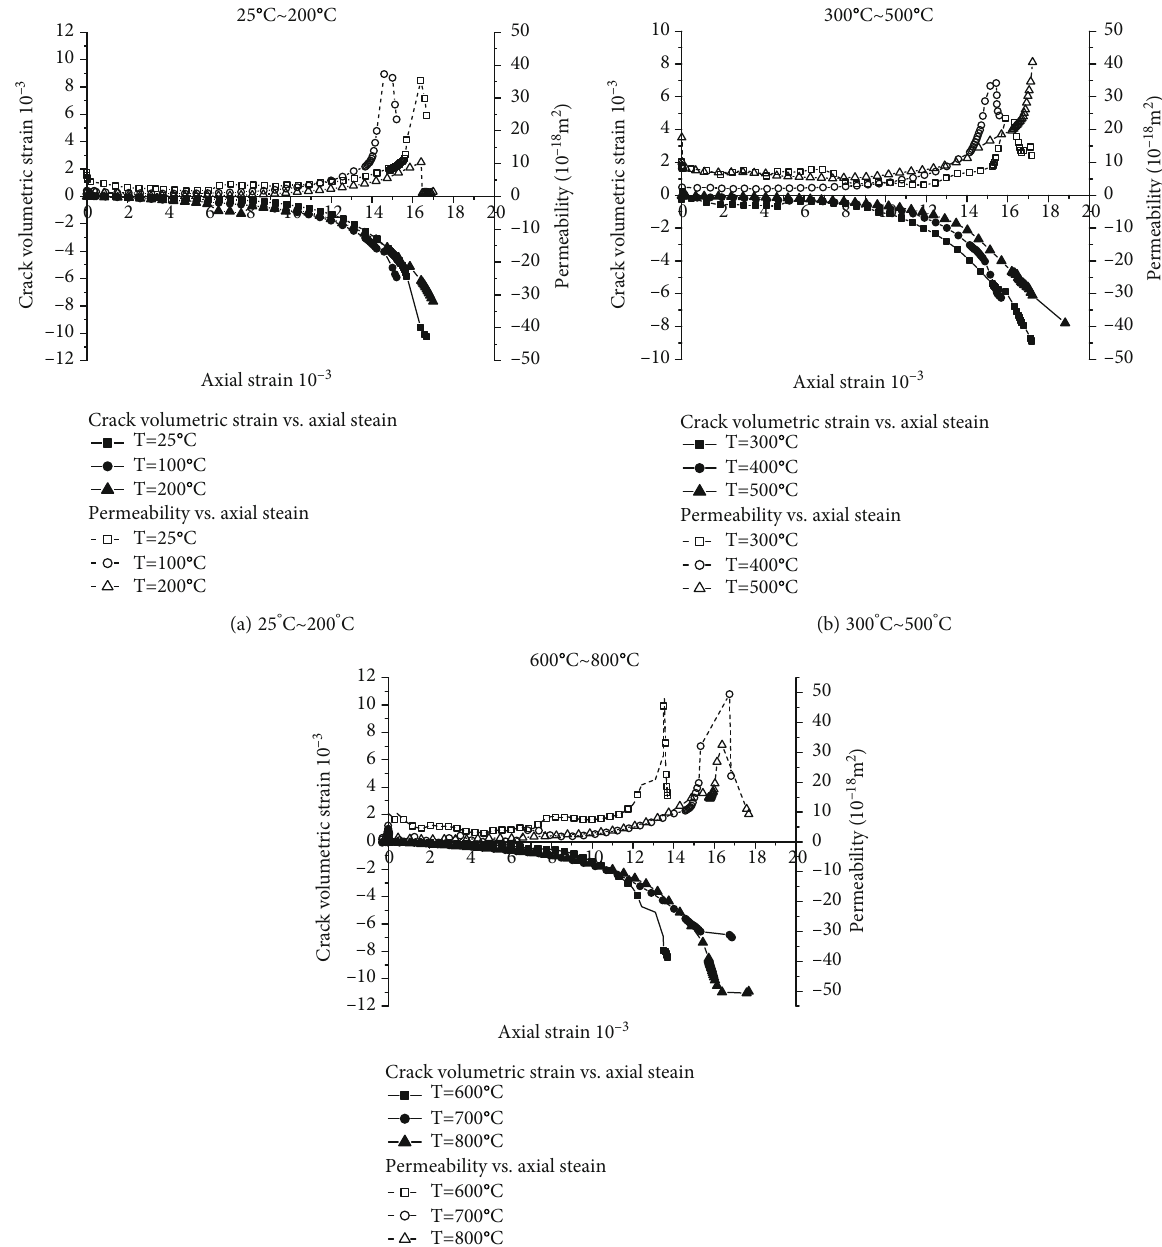
Figure 10: Permeability and crack volumetric strain variation vs. axial strain of the heat-treated